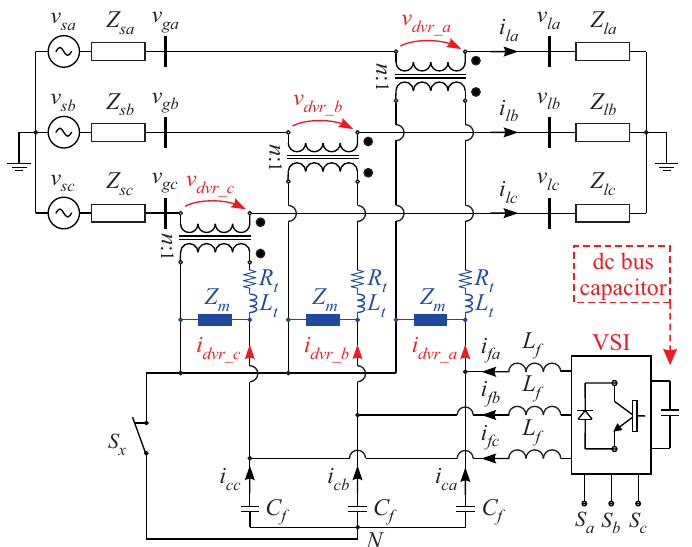
Figure 1. Three-phase circuit with a conventional three-wire dynamic voltage restorer